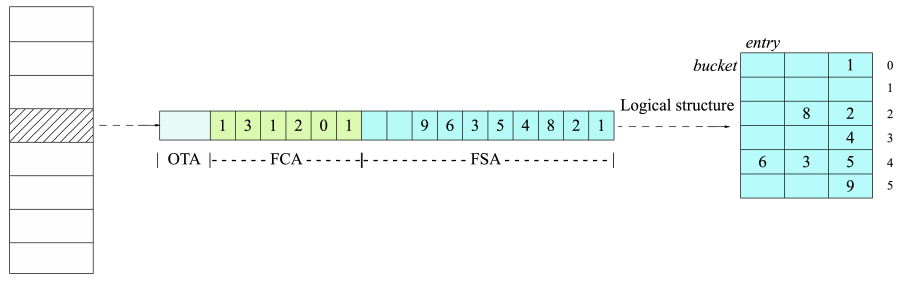
Figure 2. Morton